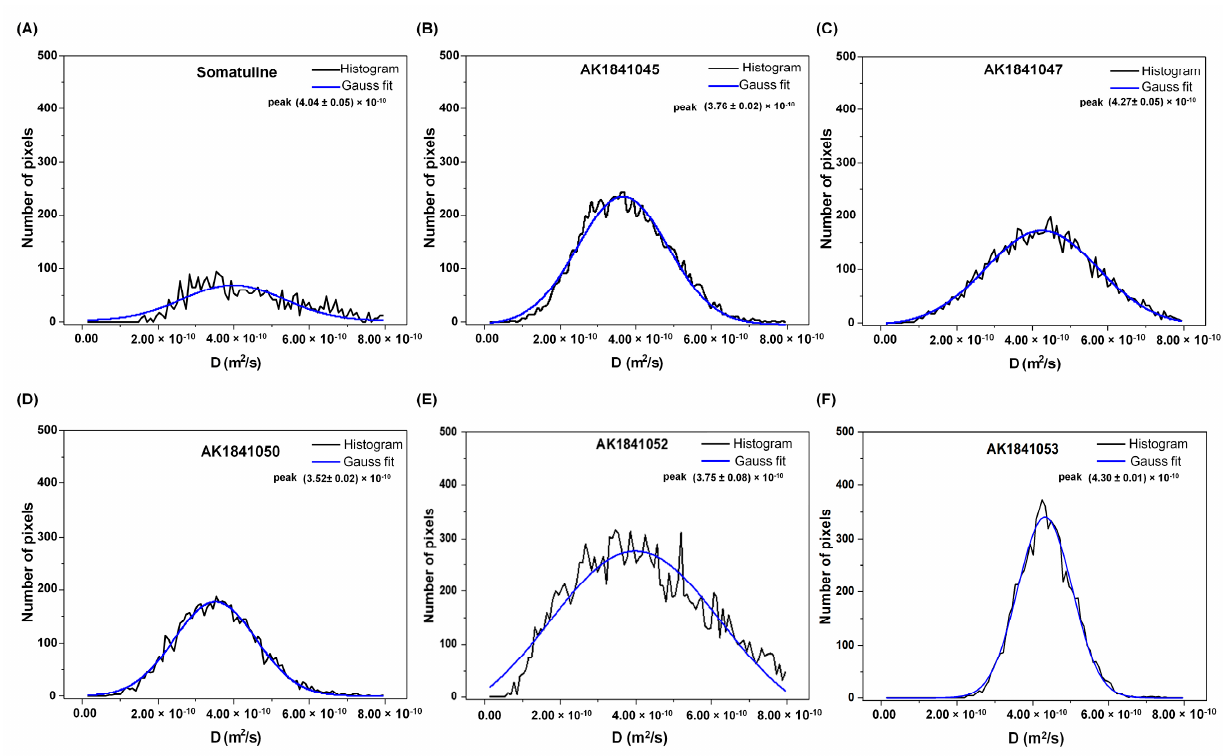
Figure 5. Gaussian distribution of the D values obtained from each pixel in the MRI DWI images of the samples: ( A ) Somatuline Autogel ® , ( B ) AK1841045, ( C ) AK1841047, ( D ) AK1841050, ( E ) AK1841052, and ( F ) AK1841053. The black lines represent the histogram distributions, and the blue lines report the Gaussian fit. For each sample, the D values are reported, which correspond to the maximum peak of the Gaussian